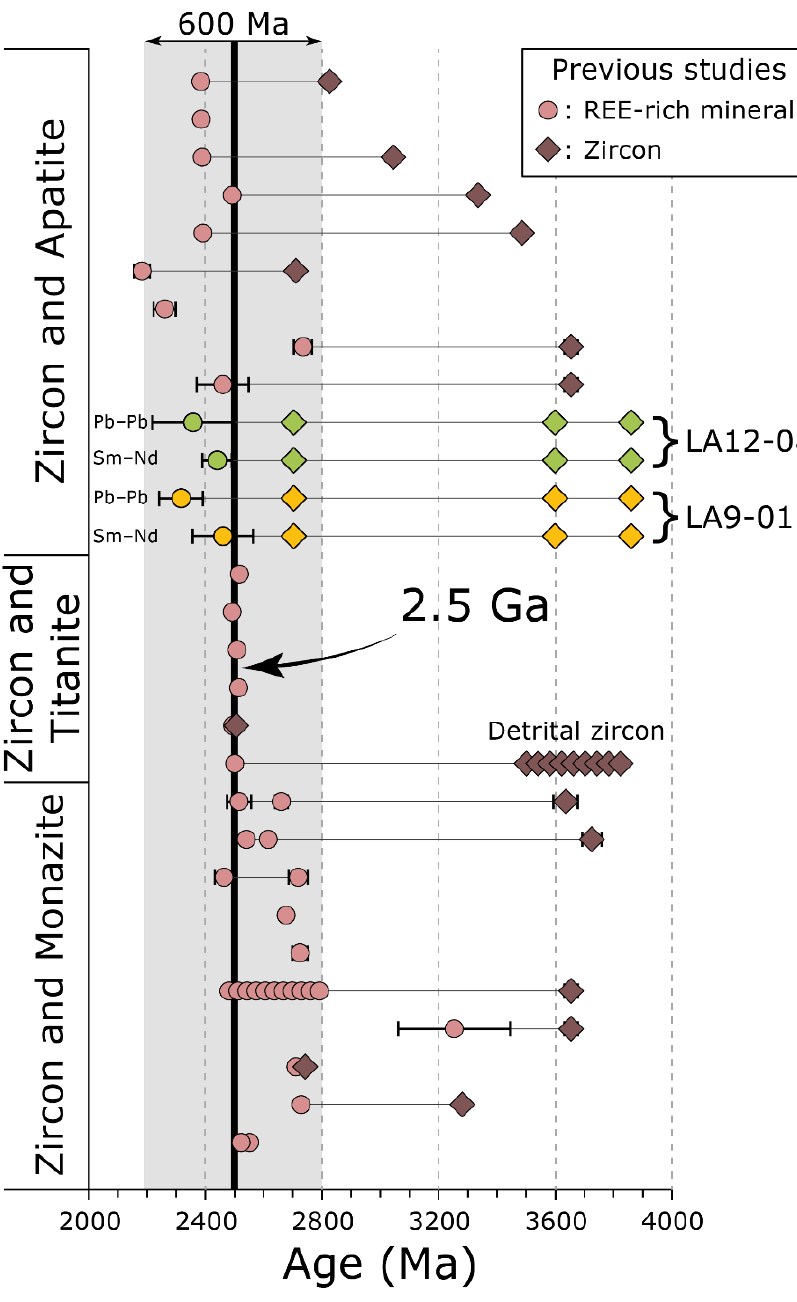
Figure 5. Compilation of REE-rich mineral ages from the Saglek Block and corresponding zircon age obtained on the same rock hand-specimen. Diamond symbols are zircon analyses, circle symbols are either apatite or titanite or monazite analyses. Each line represents one hand-specimen. Uncertainties are reported at 95% confidence interval. Data from: [5,28,30,39,40,43,47] and this study. Details about the distribution of ages and Hf–Nd isotopes signatures are shown in Figure 6.